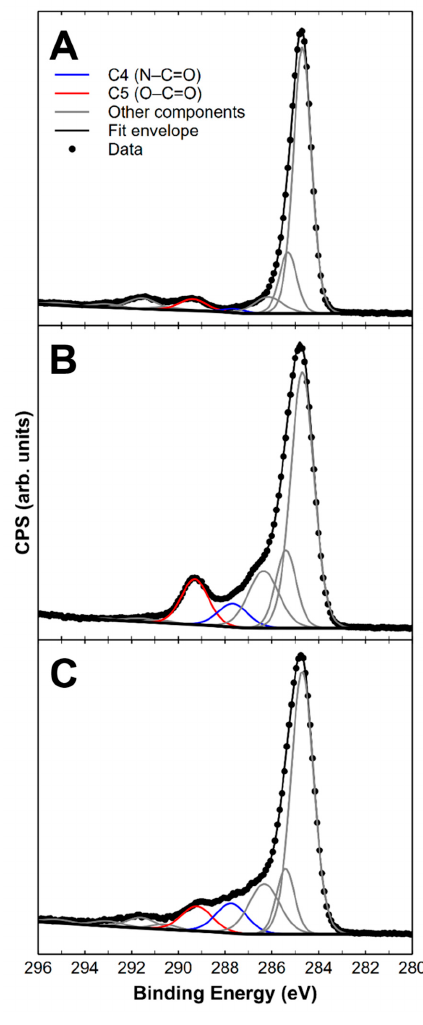
Figure 2. Carboxylic group introduction using UV-ozone. High-resolution C 1s spectra with peak fitting of the commercially available COOH functionalised PS sphere monolayers with silica deposition on gold electrodes after ( A ) no UV-ozone treatment, ( B ) 1 min UV-ozone treatment and ( C ) 1 min UV-ozone treatment followed by EDC/NHS activation and streptavidin incubation. Compo- nents 4 and 5, assigned to N-C=O and O-C=O groups, respectively, are highlighted in blue and red, respectively. Prior to EDC/NHS activation and streptavidin incubation, component C4 in ( B ) would be primarily associated with C=O and O-C-O groups generated during UV-ozone treatment.